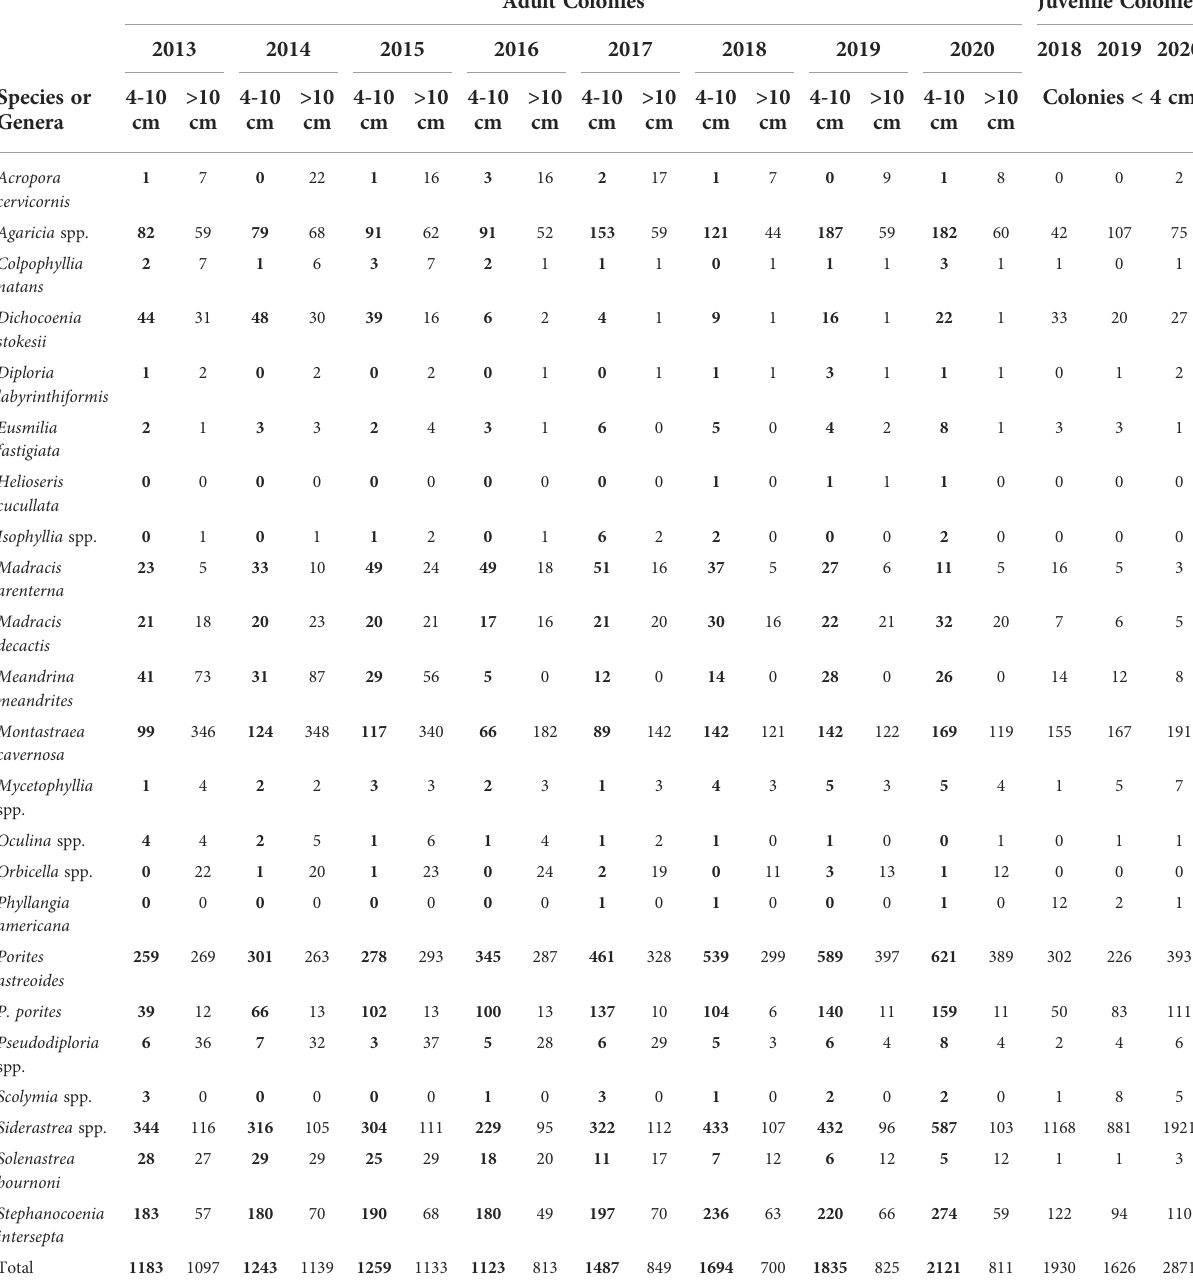
TABLE 3 Abundance of small adult (bold, 4-10 cm), adult (> 10 cm) and juvenile (< 4 cm) stony corals (classi fi ed by maximum colony